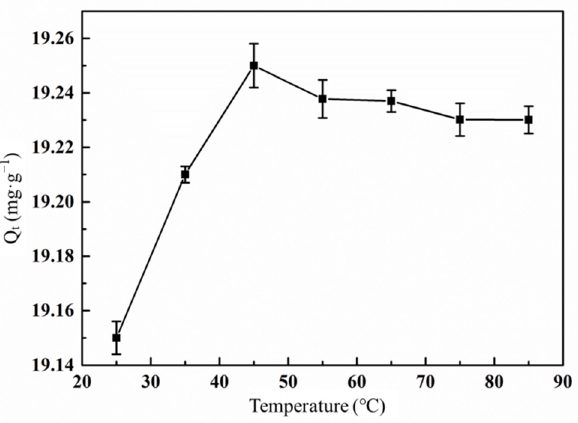
Figure 12. Effect of treatment temperature on the adsorption of Hg(II) ions by the graft polymer (contact time 120 min; pH value 5.5; initial concentration of Hg(II) ion 15 mg · L − 1 ).